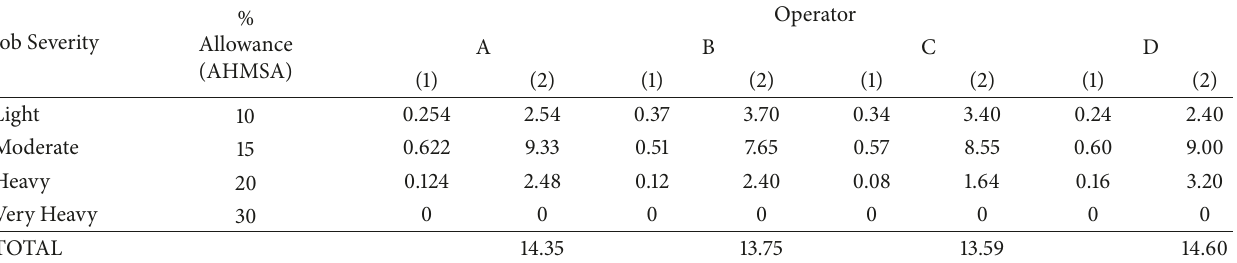
Table 5: Allowance percentage determined from the study for each